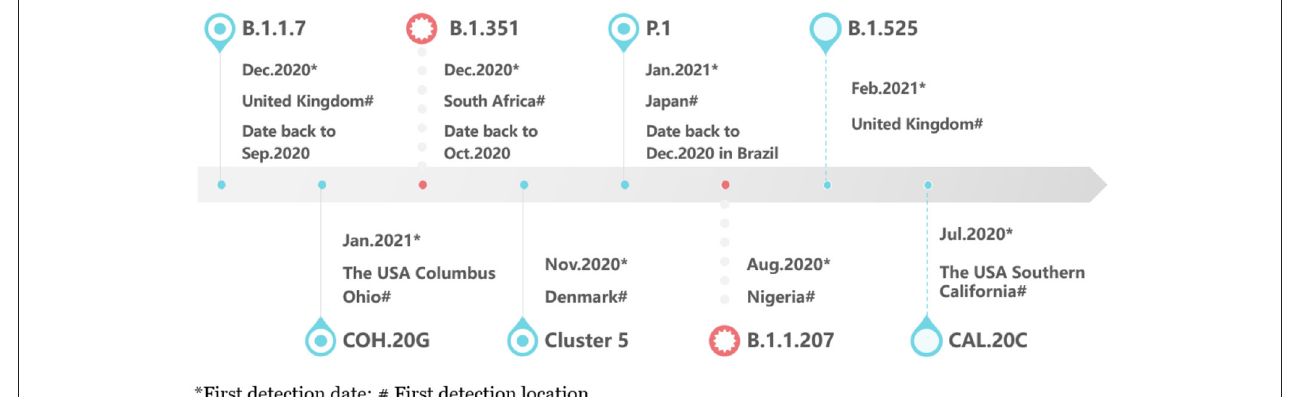
FIGURE 1 | The timeline of new variants.